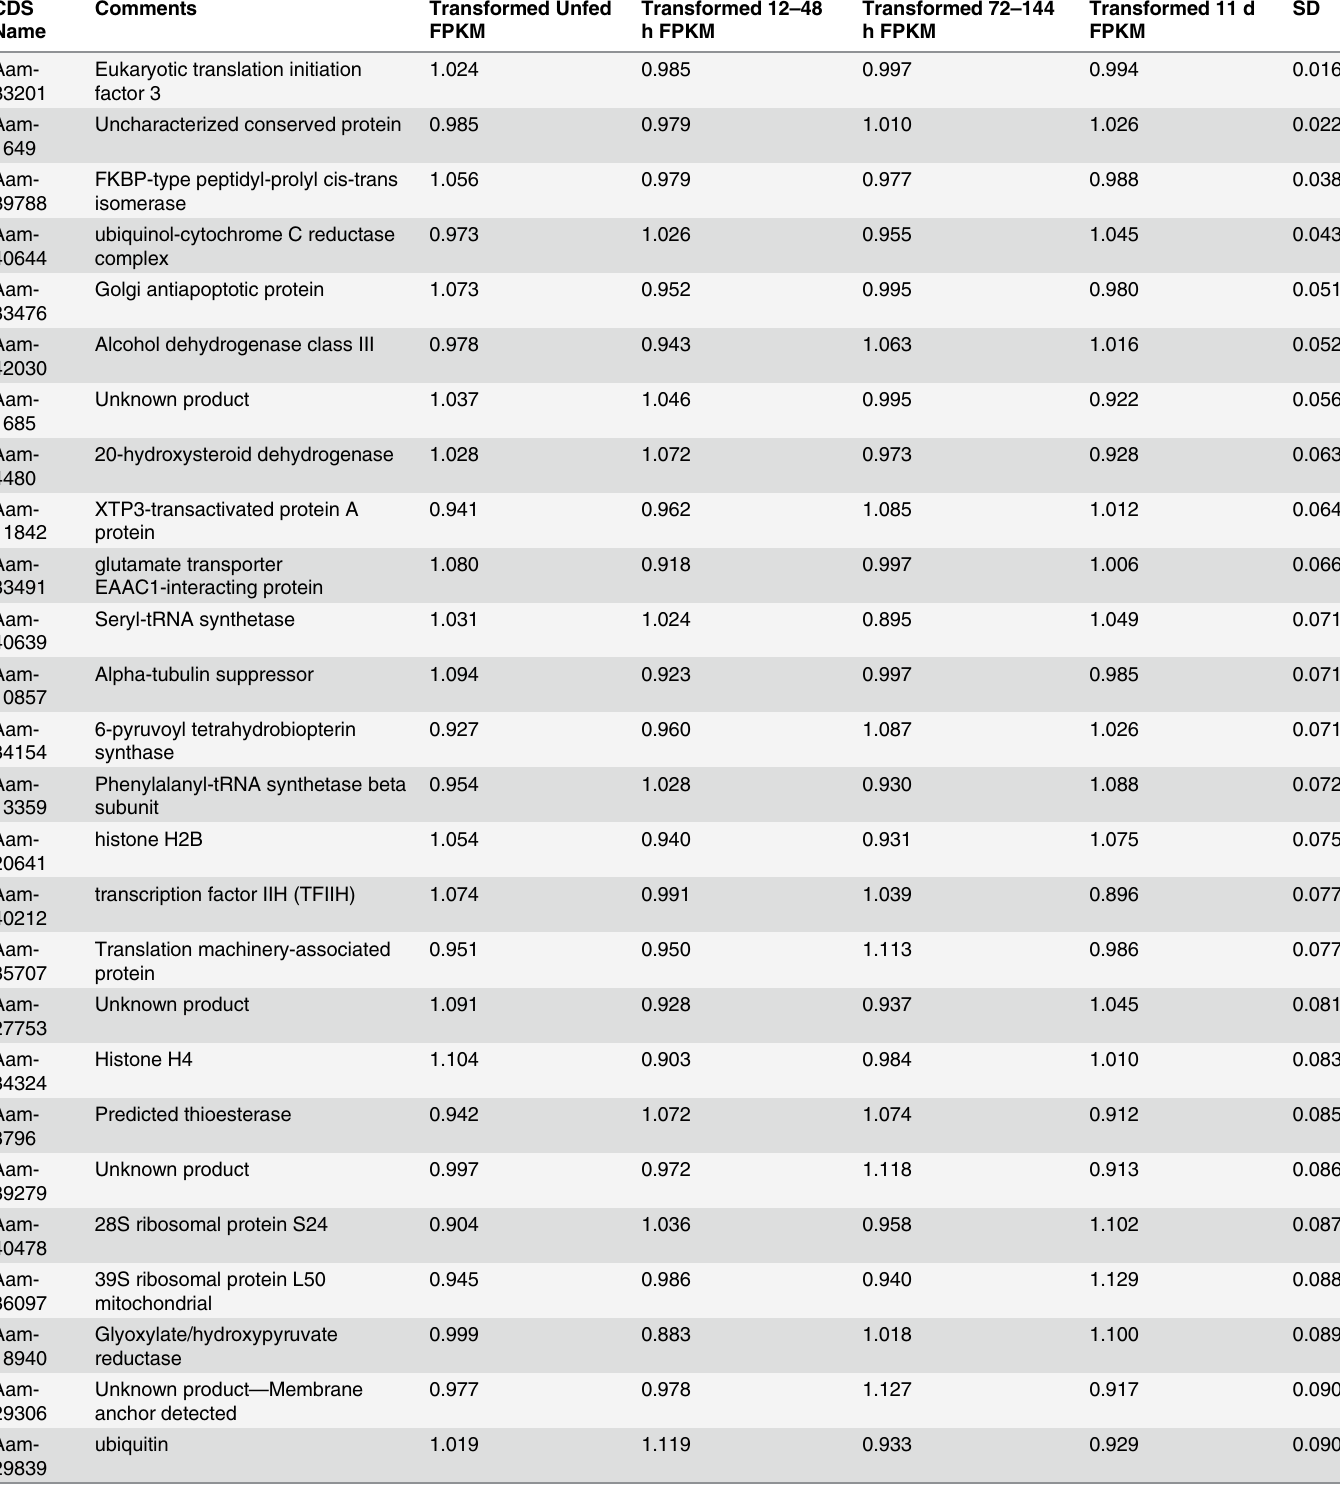
Table 3. Time-invariant expressed